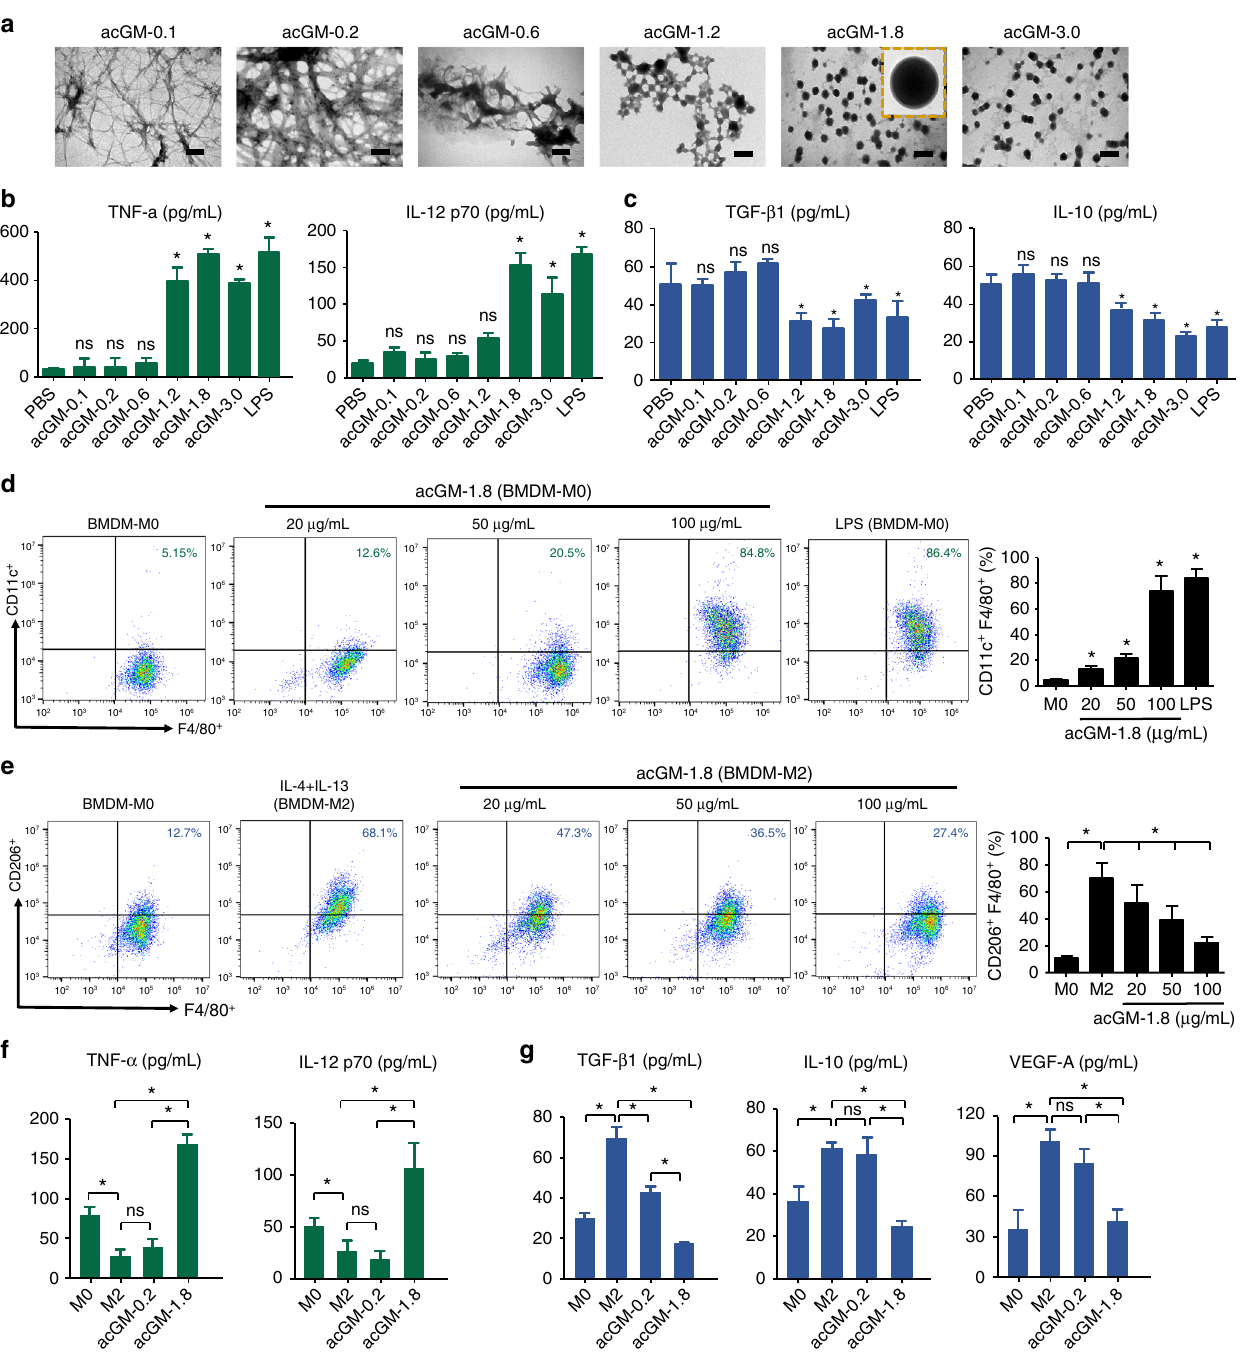
Fig. 2 acGM-1.8 stimulates macrophages into a proin fl ammatory phenotype. a Representative TEM images of a series of acetyl glucomannan (acGM) samples with different degrees of acetylation (scale bar: 500 nm). b Determination of proin fl ammatory cytokines – tumor necrosis factor- α (TNF- α ) and interleukin-12 (IL-12 p70) and ( c ) anti-in fl ammatory cytokines – transforming growth factor- β 1 (TGF- β 1) and interleukin-10 (IL-10) – secreted by primary murine bone marrow-derived macrophages (BMDM) after 24 h of stimulation by acGM samples (* P < 0.05 vs. the phosphate buffer saline [PBS] group; ns: no signi fi cance; n = 3). d Flow cytometry analysis of CD11c in BMDM after stimulation with acGM-1.8 (20, 50, and 100 µ g/mL; * P < 0.05 versus the BMDM-M0 group; ns: no signi fi cance; n = 3). e Flow cytometry analysis of CD206 in BMDM that were pre-induced into M2 phenotype and then stimulated with acGM-1.8 (20, 50, and 100 µ g/mL; * P < 0.05 versus the BMDM-M2 group; ns: no signi fi cance; n = 3). f , g ELISA analysis of ( f ) proin fl ammatory (TNF- α and IL-12 p70) and ( g ) anti-in fl ammatory cytokines (TGF- β 1, IL-10, and VEGF-A) expressed by BMDM that were without treatment, induced into the M2 phenotype, and induced into the M2 phenotype followed by acGM-1.8/0.2 treatment (* P < 0.05 versus BMDM in the M2 phenotype; ns: no signi fi cance; n = 3). The data are representative for three independent experiments